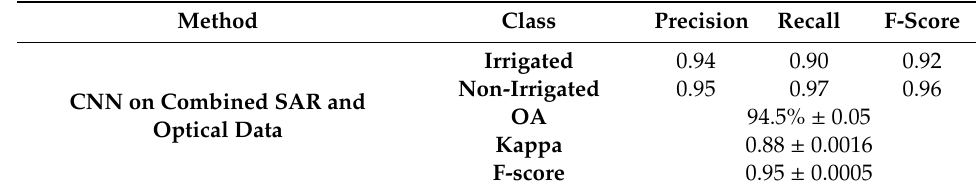
Table 9. The values of the overall accuracy, Kappa, F-score, precision, and recall obtained from the CNN method on combined SAR and optical